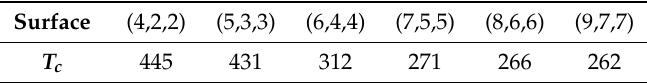
Table 3. Critical temperatures ( T c ) of Fe wires on the vicinal Cu(111) surfaces for the MAE of 4.76 meV. The temperature values are given in